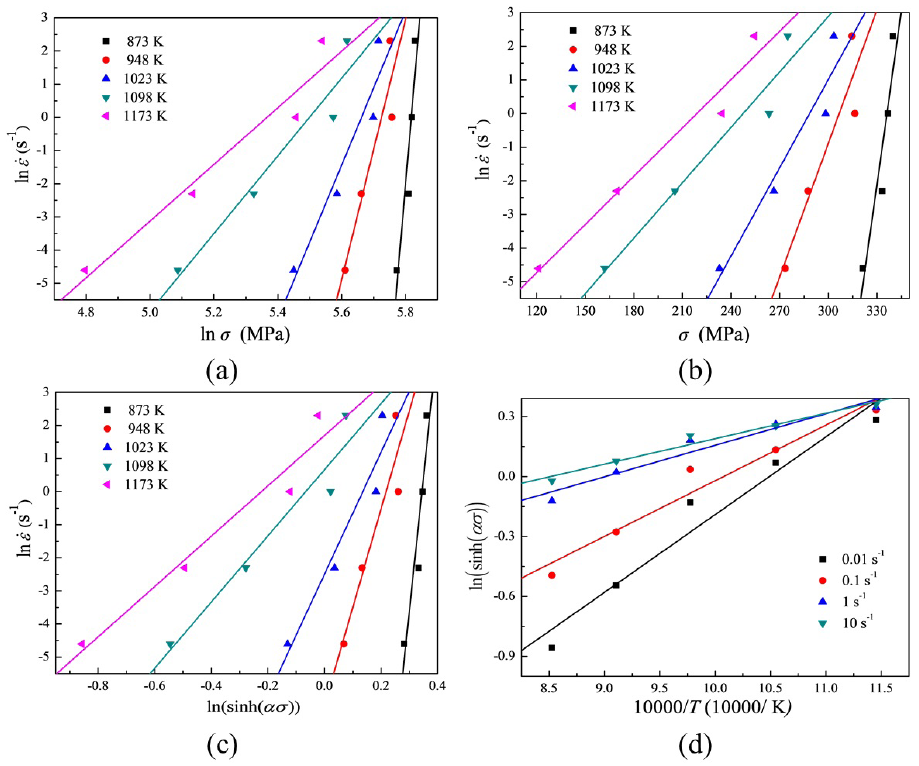
Figure 8. Relationships between (a) ln